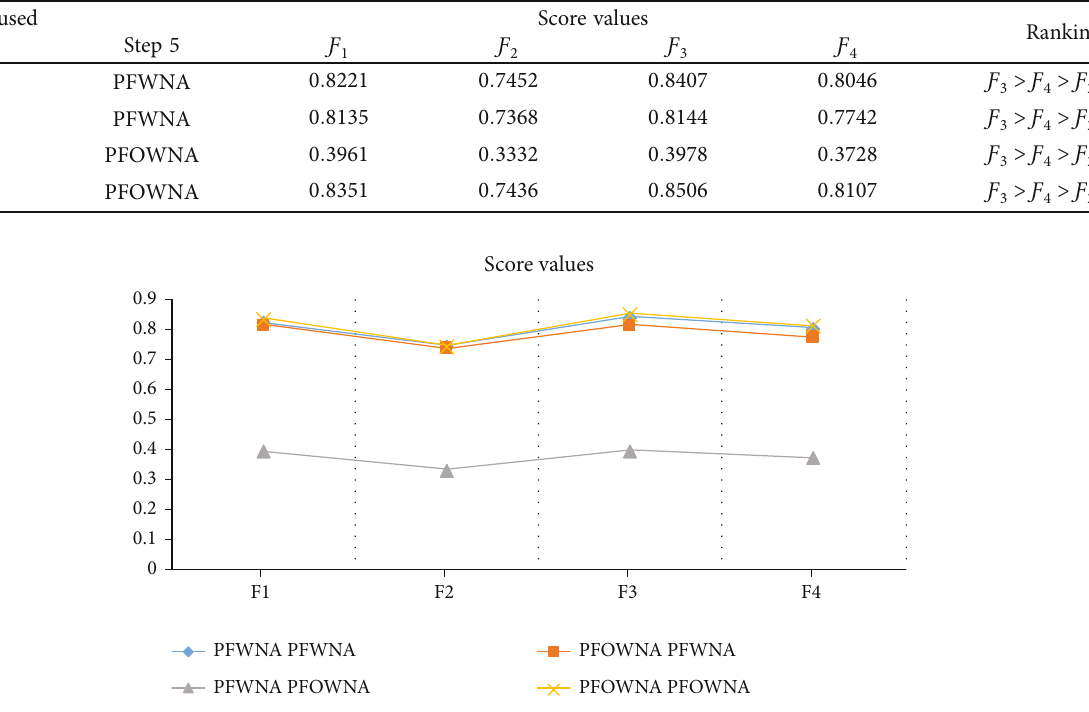
Table 4: In fl uence of alteration of AOs and ranking order.